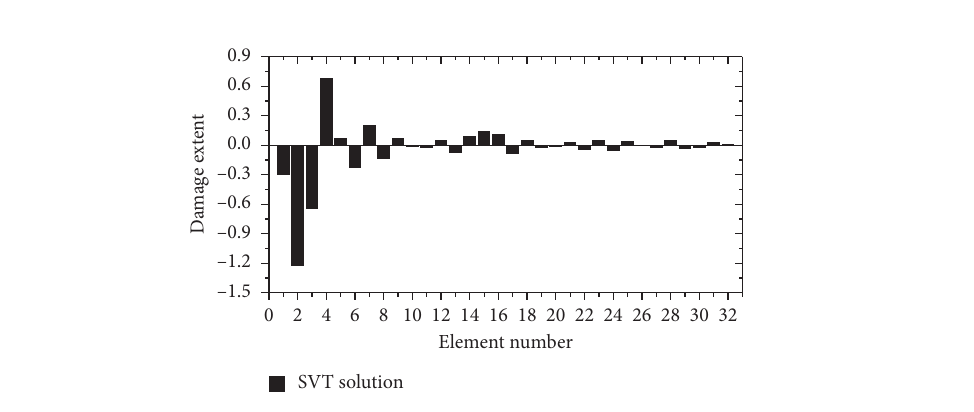
Figure 1: A reinforced concrete beam (unit: mm).